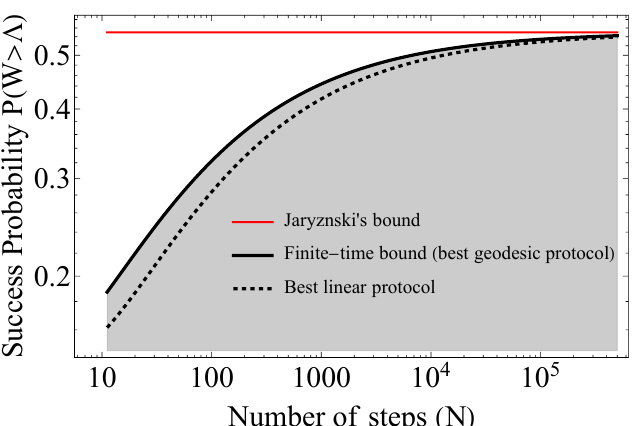
Figure 3: In this figure we illustrate the main result of this article, a finite-time bound on P ( W ≥ Λ ) , which tends to Jarzynski’s bound in Eq. 3 in the asymptotic limit. More ( W ≥ Λ ) given in (42), which provides a bound on all possible precisely, we plot P max protocols, as a function of the number of steps N . For comparison, we also show the best linear protocol, obtained by optimising over E and E all protocols with a linear a b = 6., E = 0.1, Λ = − 2 ∆ F driving of E ( t ) . Parameters: β = 2., E i f